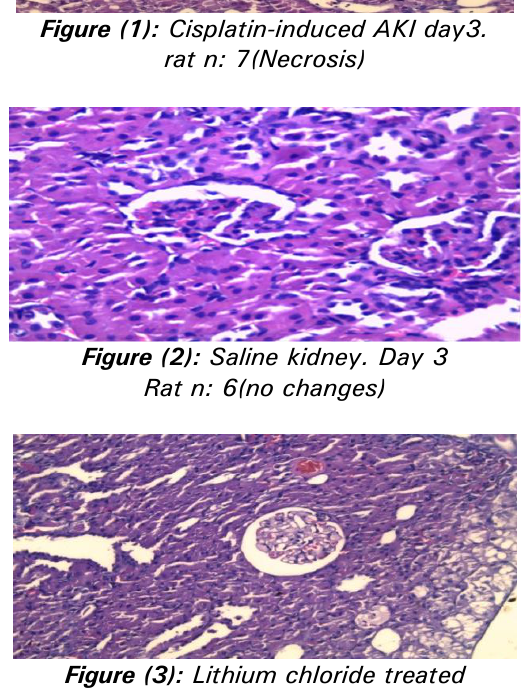
Figure (3): Lithium chloride treated rats. Day 5: rat n: 5(Cellular vacuolization & foal loss of brush border)